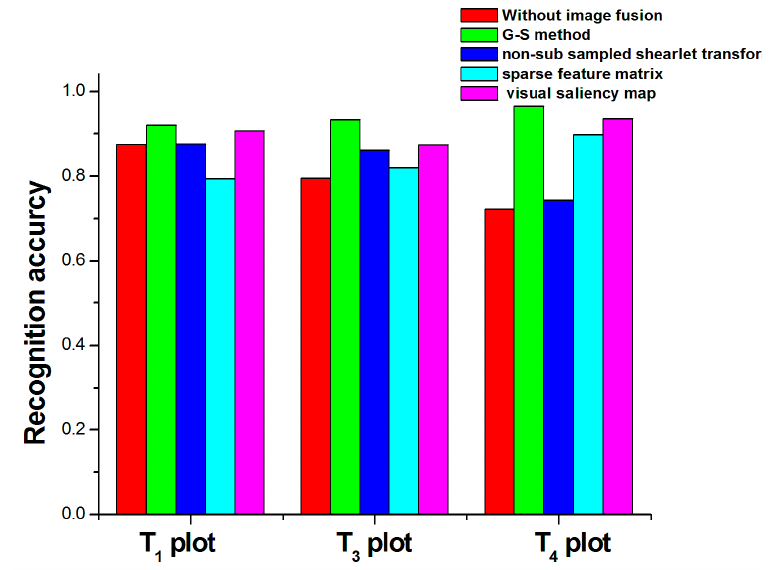
Figure 8. Accuracy of wheat ear recognition with different image fusion methods and without image fusion.